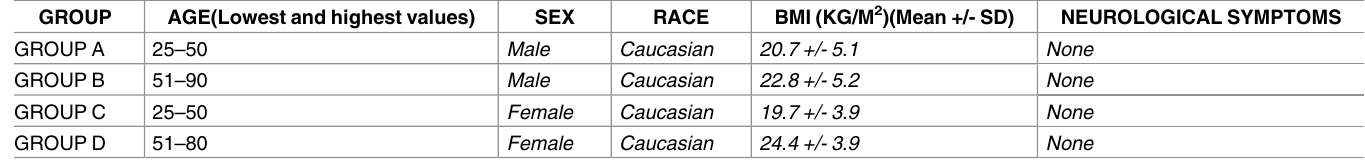
Table 1. Demographic data of our sample.